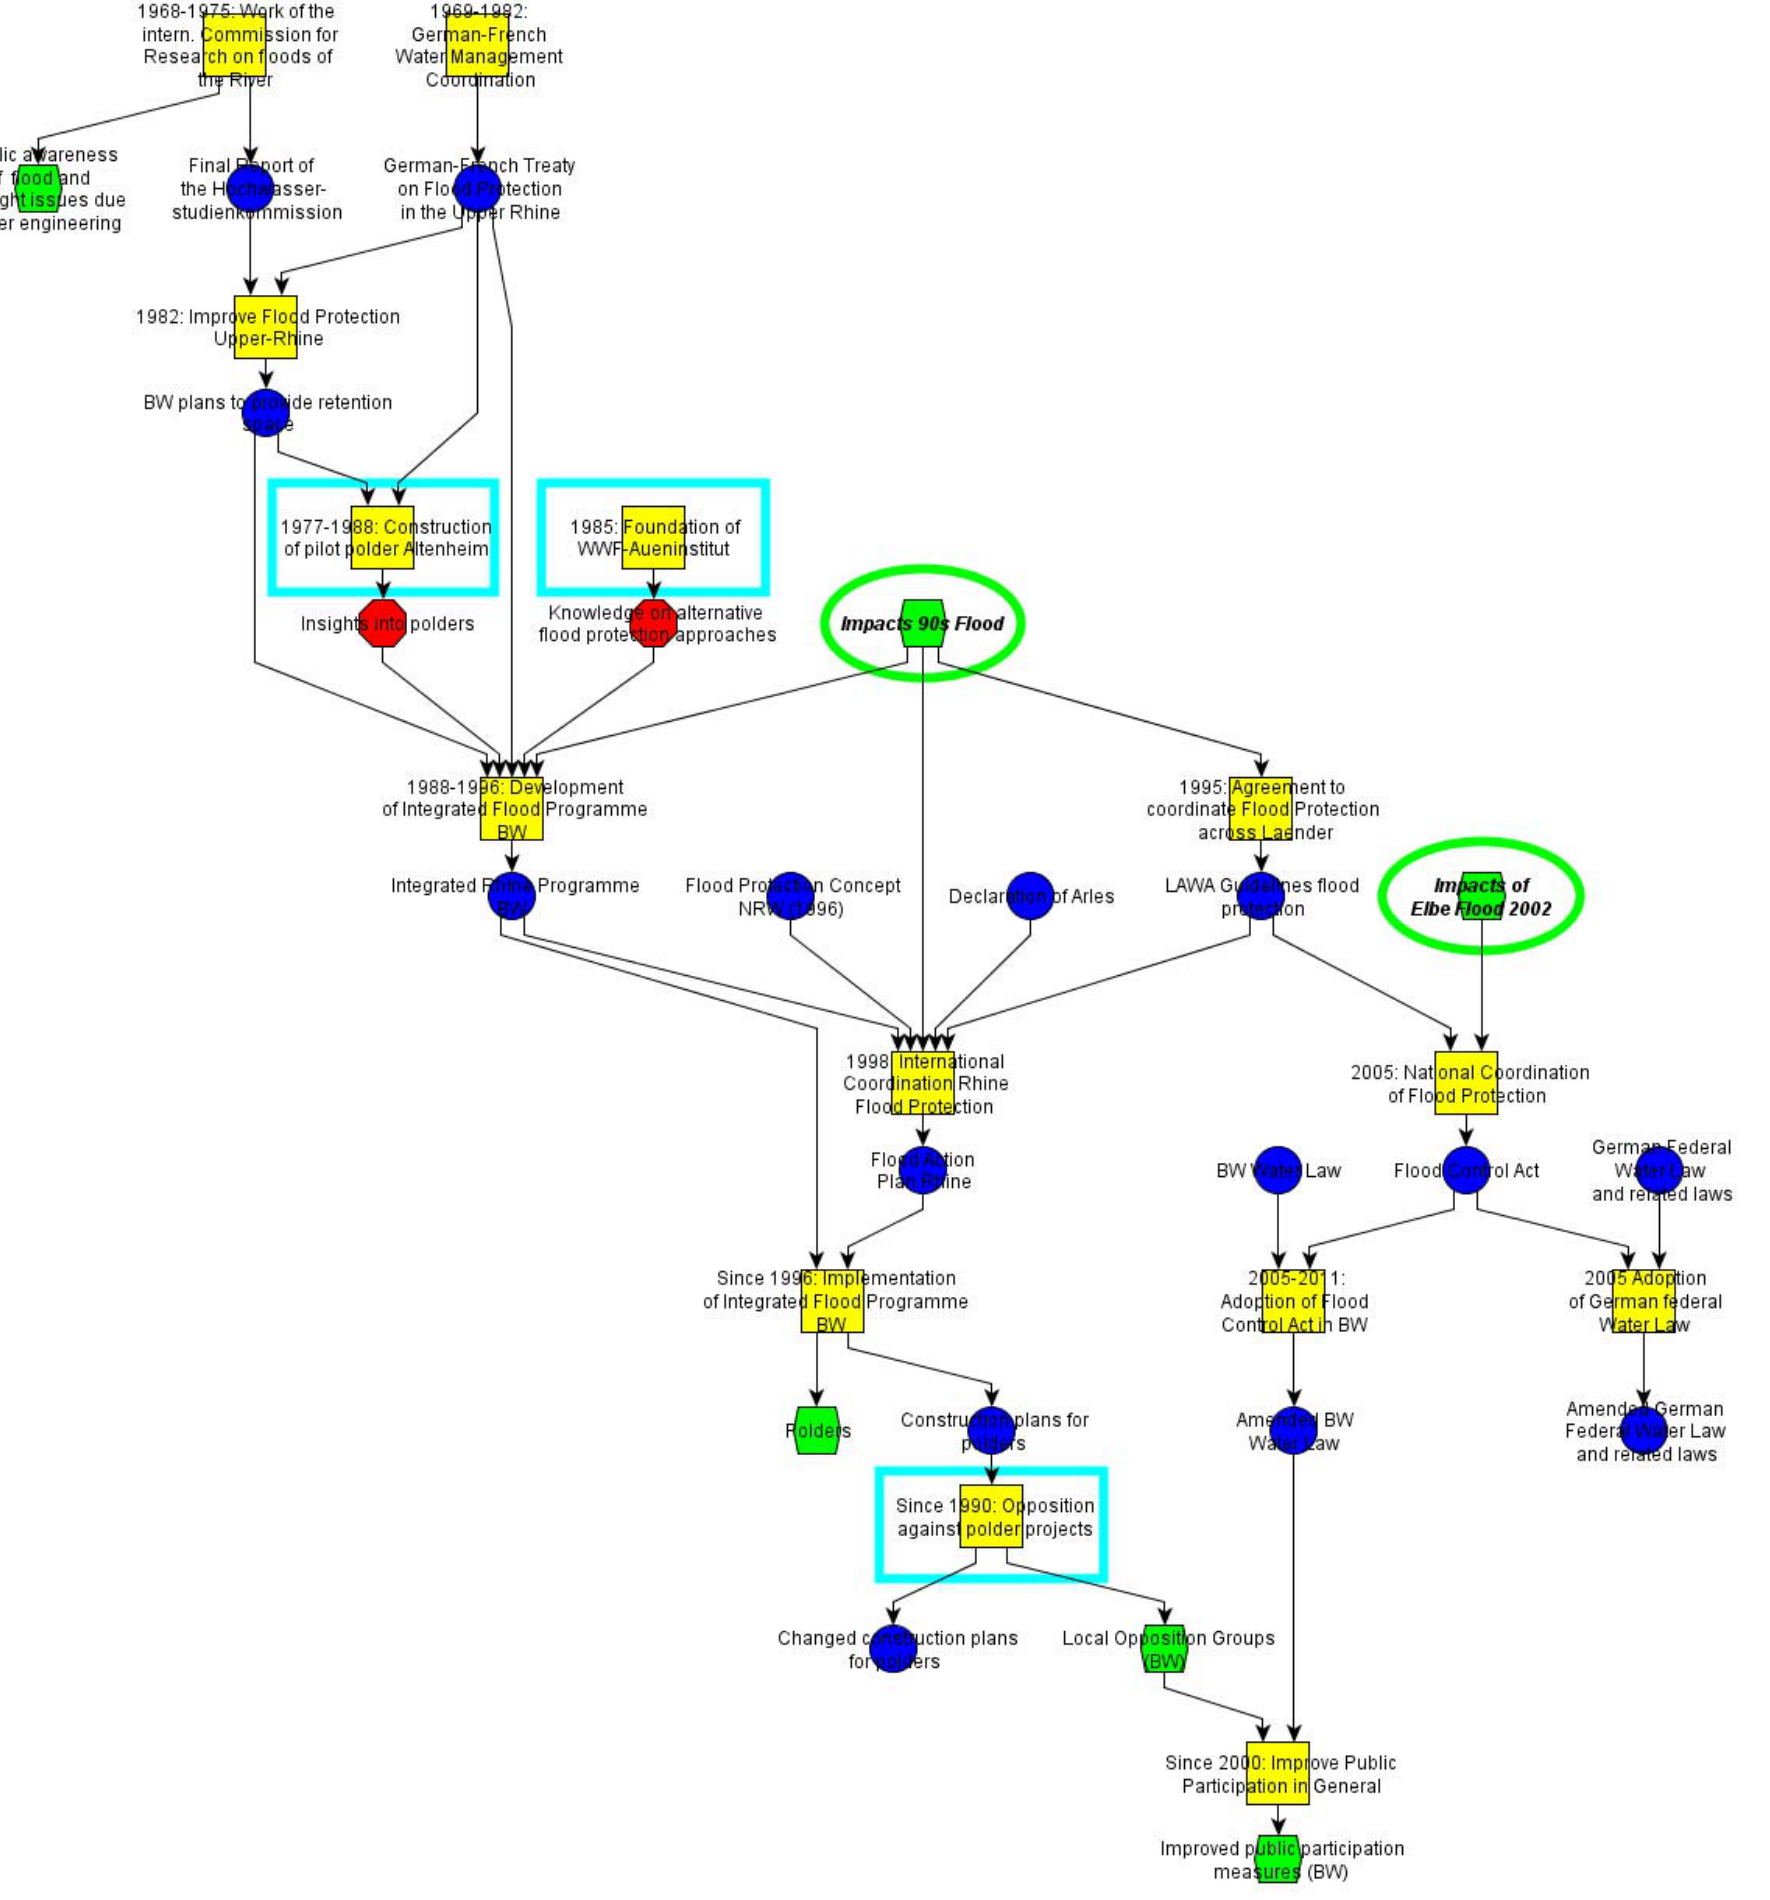
Figure A6. Rhine Germany: Network of action situations (ASs) linked by institutions (blue ball), knowledge (red octagon) or operational outcomes (green hexagon). Learning AS are marked by a turquois rectangle. Extreme events and their impacts on public perception and policy response are marked by a green